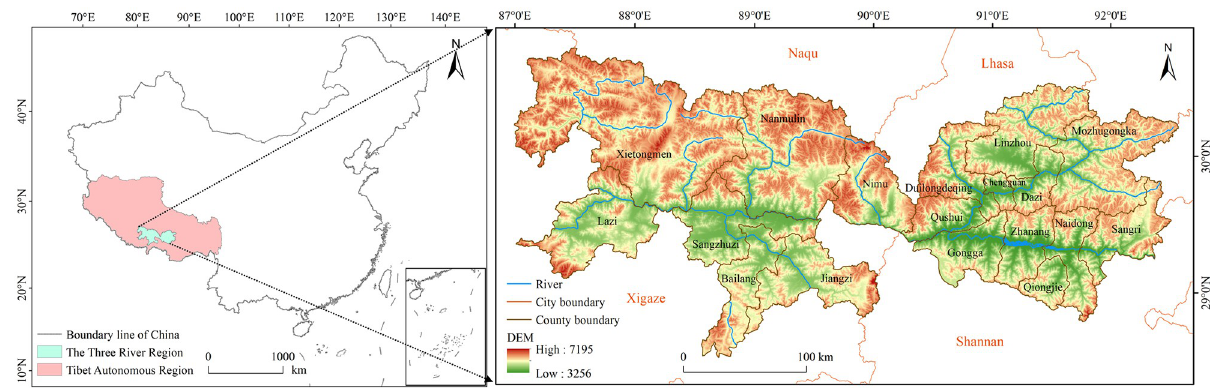
Fig 1. Location and terrain map of the Three River Region. The map was prepared with ArcGIS10.1 (https://resources.arcgis.com/en/help/), based on the maps of China political boundaries and rivers from the Resource and Environment Science and Data Center, CAS (https://www.resdc.cn/), with the permission of its copyright, and ASTER Global Digital Elevation Model V2 [28] courtesy of NASA Earth Data (https://earthdata.nasa.gov/).